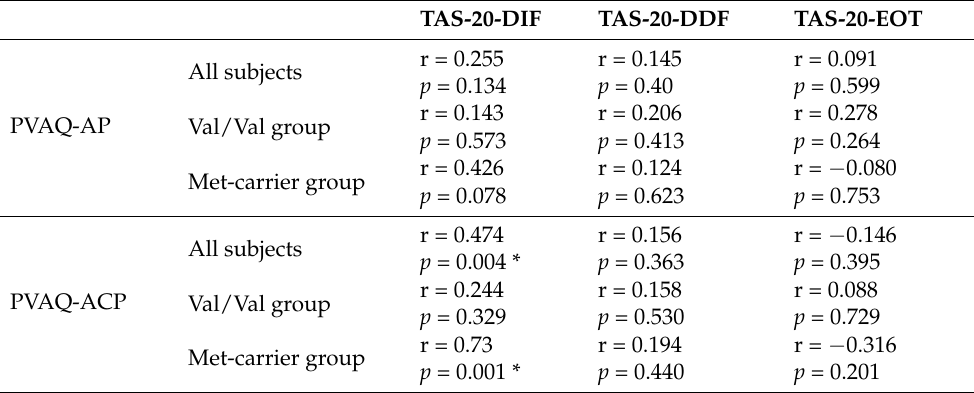
Table 2. The relationship between each subscale for PVAQ and